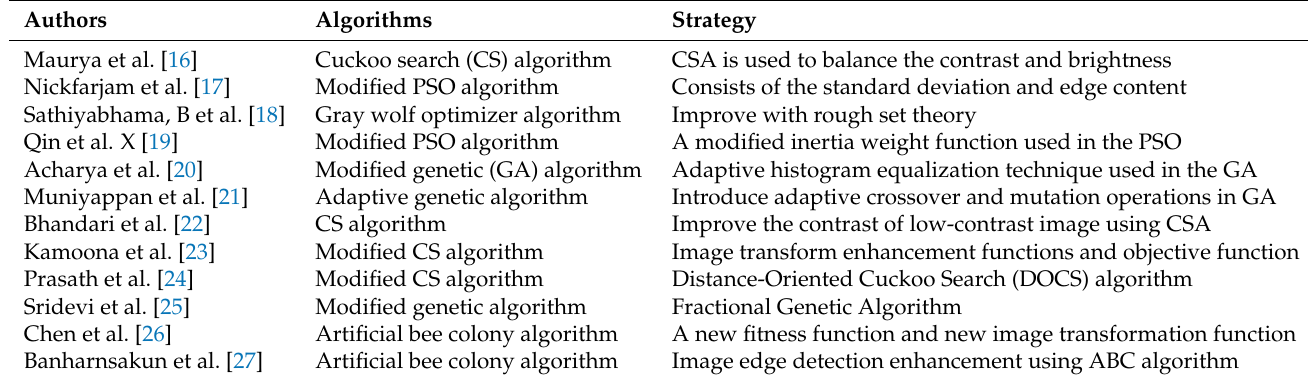
Table 1. Swarm intelligence optimization algorithms for image